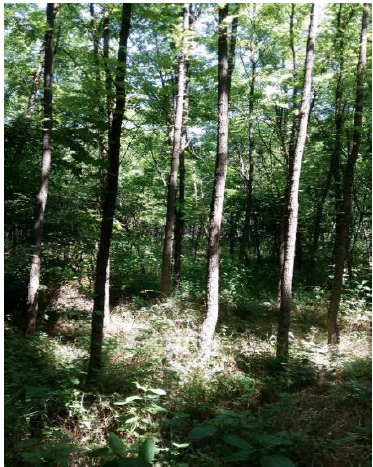
Figure 2. R.p. ’Üllői’ cultivar plantation at